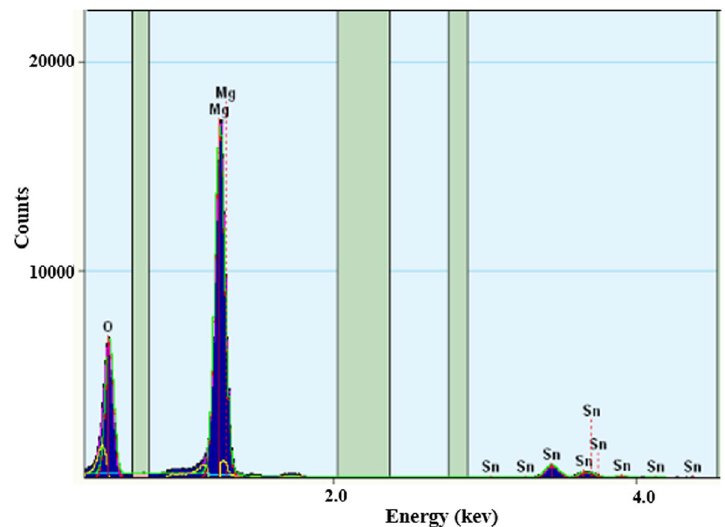
Fig. 5 EDS map for MgO-SnO 2 nanocomposite